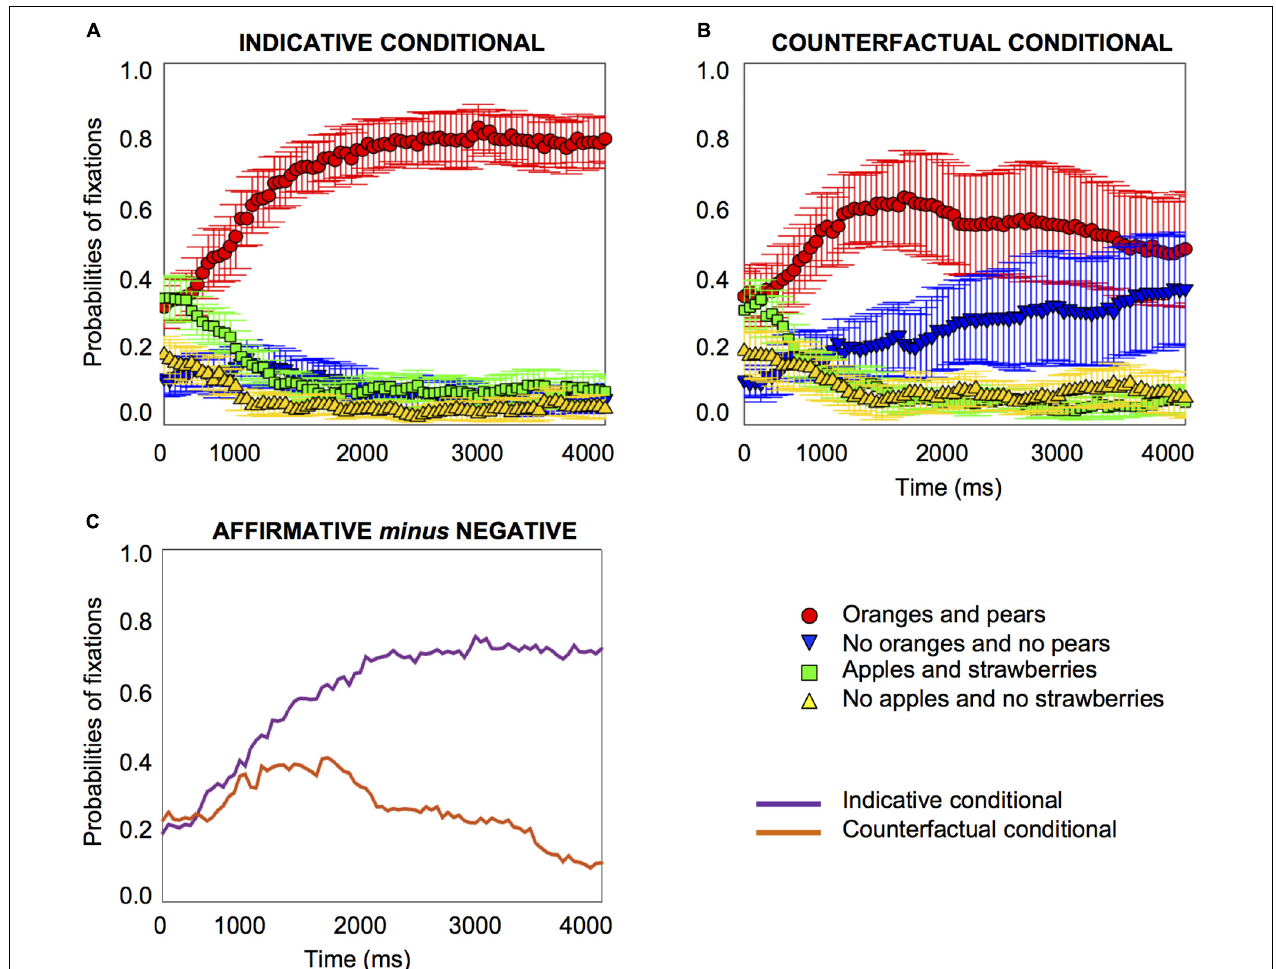
FIGURE 5 | Probabilities of fixations for indicative conditionals, e.g., “if there are oranges, then there are pears” (A) and counterfactual conditionals, e.g., “if there had been oranges, then there would have been pears” (B) in Experiment 2. The differences in the probabilities of fixations (on the affirmative image minus the negative image) for indicative and counterfactual conditionals emerge at 1700 ms, as (C) shows. Error bars are 95% confidence intervals within